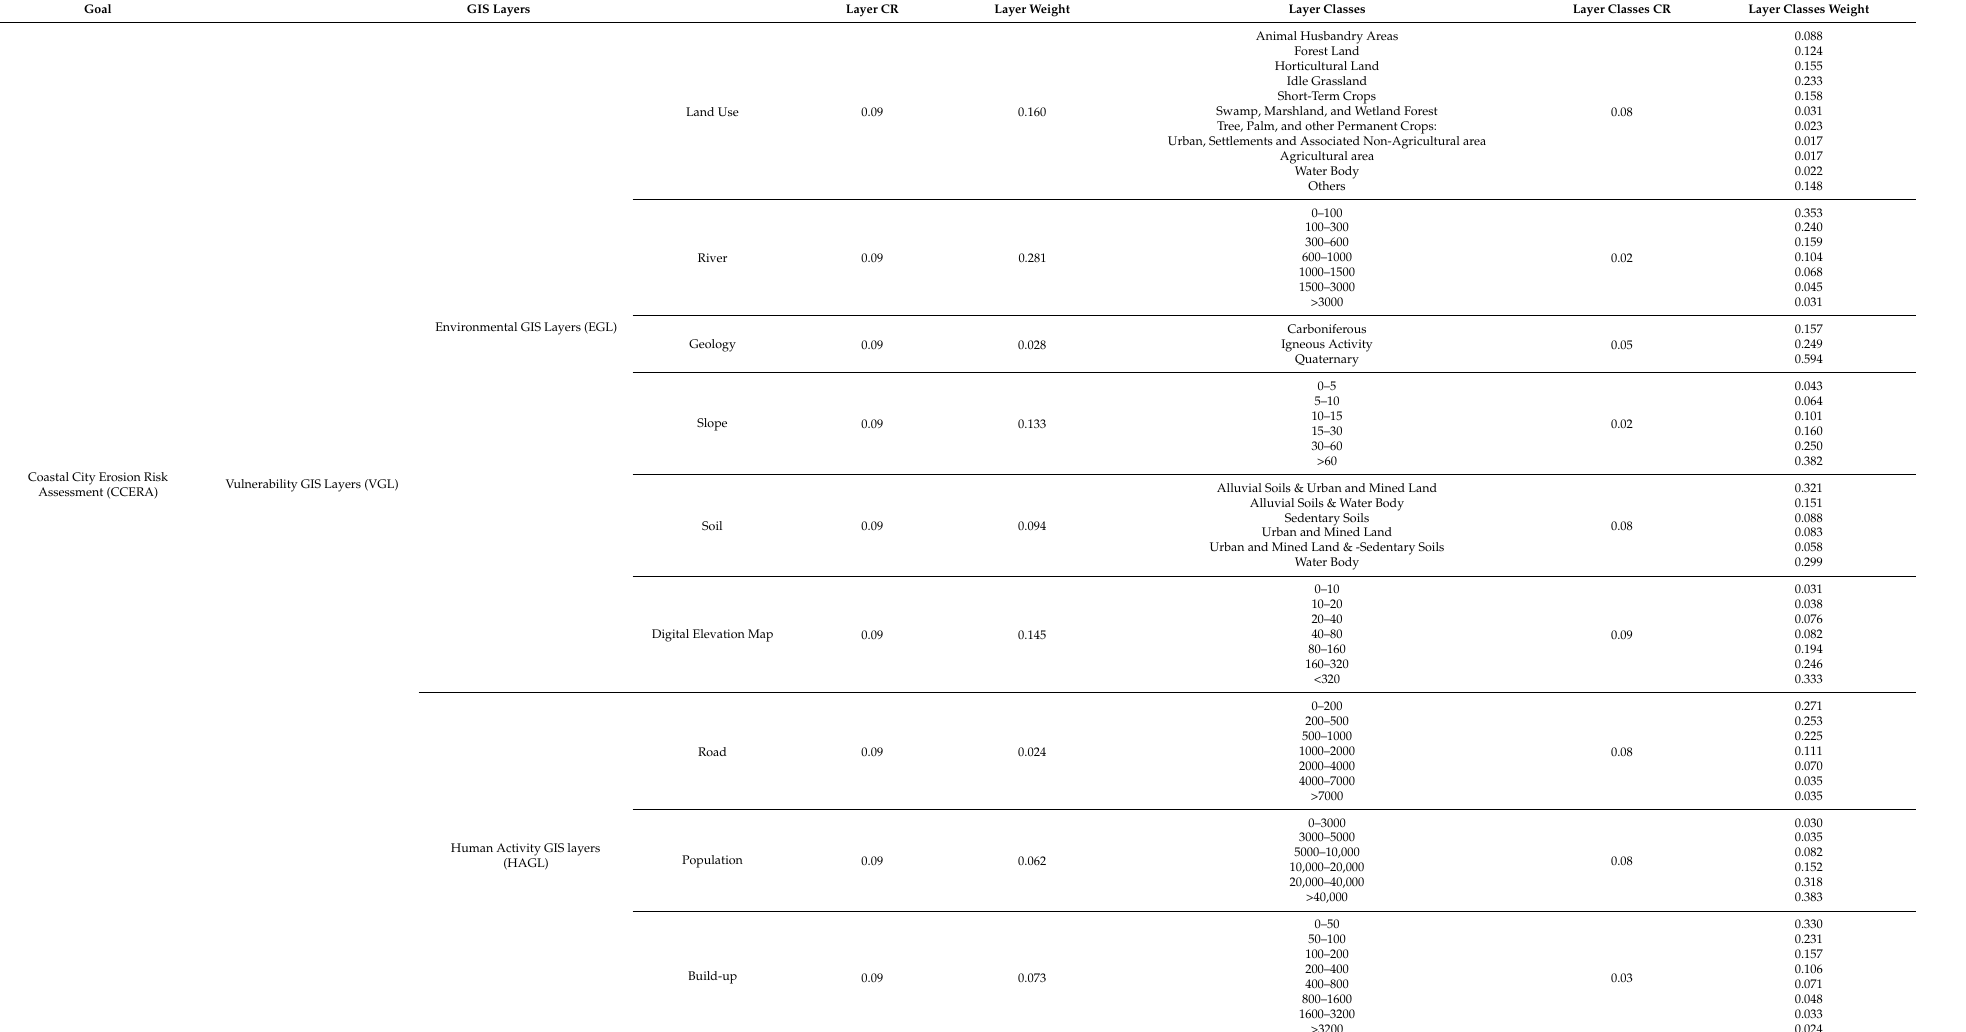
Table 3. Vulnerability GIS Layers class and